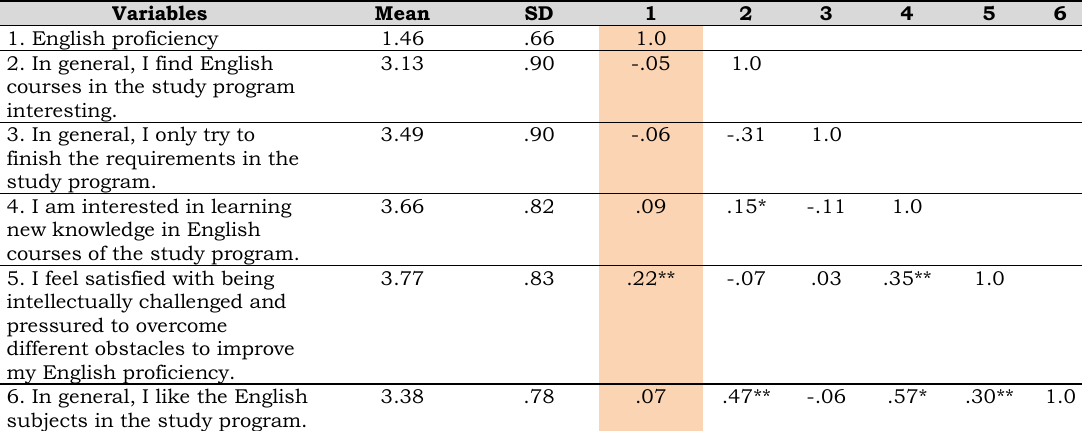
Table 3: Correlation Matrix (observed variables) of students’ EP and